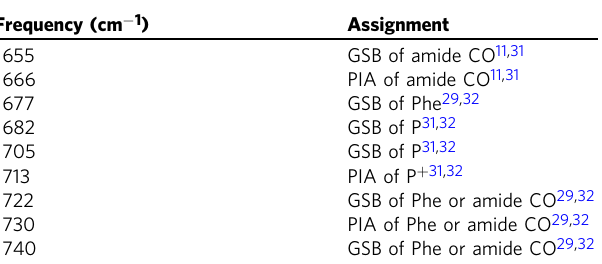
Table 1 IR frequency assignments of the